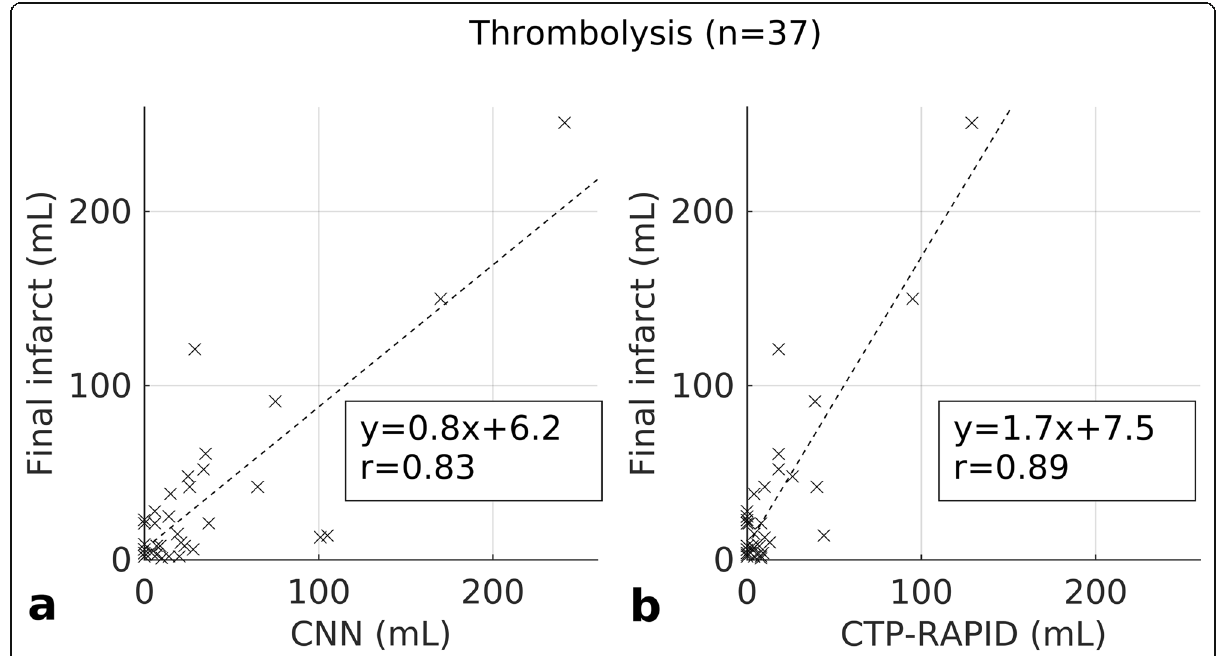
Fig. 6 Infarct lesion volume correlation in patients treated with intravenous thrombolysis. Convolutional neural network (CNN) predictions versus